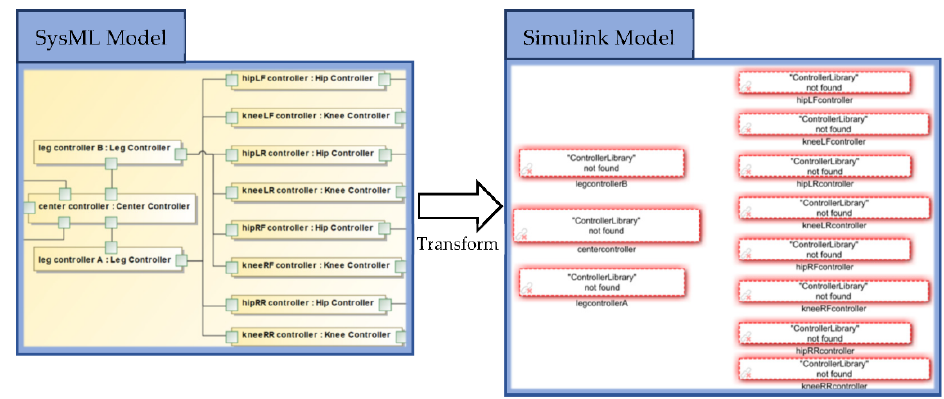
Figure 15. The transformation of the quadruped robot’s logical architecture based on the conventional transformation method.